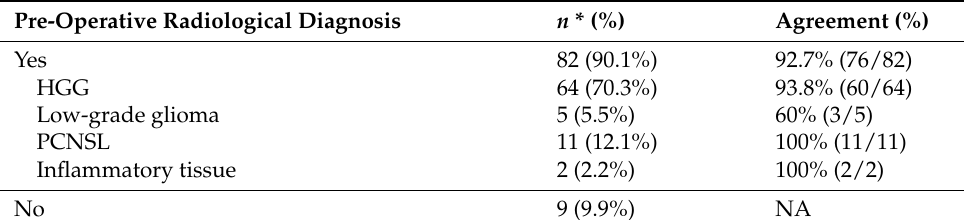
Table 2. Agreement between pre-operative suspicion and histology. Pre-Operative Radiological